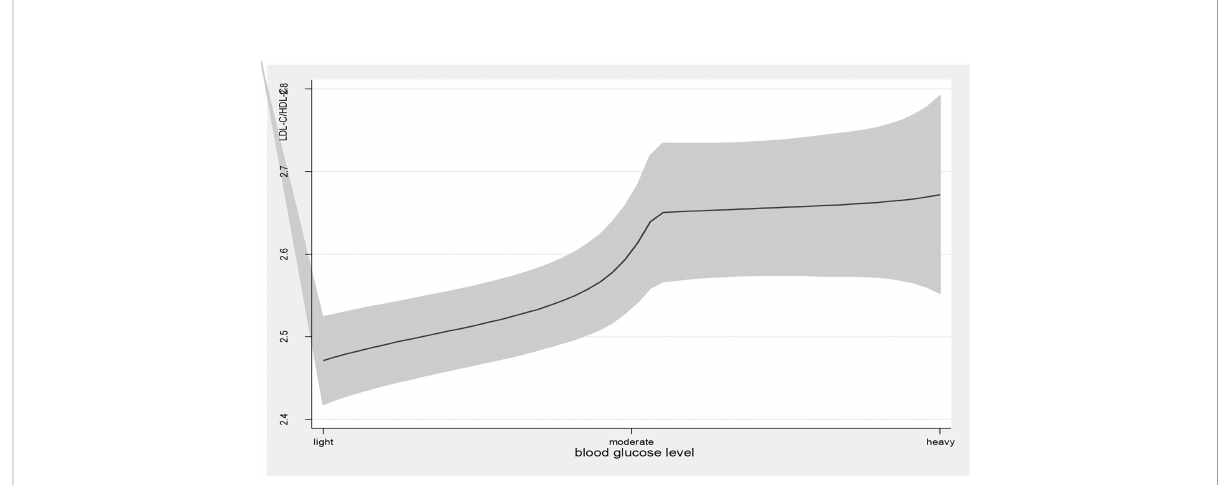
FIGURE 4 the level of LDL-C/HDL-C with the change of blood glucose level. with the high level of blood glucose, the LDL-C/HDL-C level was higher. line represent the value of LDL-C/HDL-C, the gray con fi dence intervals represent the 95% con fi dence intervals of